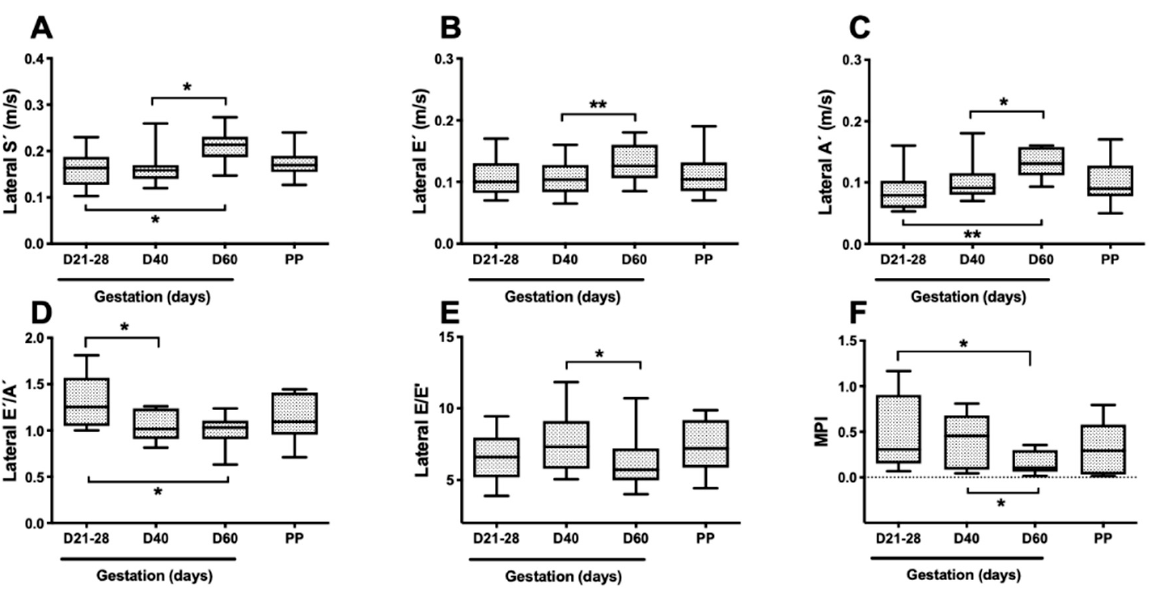
Figure 1. Box and whiskers plot showing LV systo-diastolic function assessed by TDI ( A – E ) and MPI ( F ). TDI parameters were obtained at the lateral margin of the mitral annulus. S’, peak systole in ejection phase; E’, peak myocardial velocity during early diastole; A’, peak myocardial velocity during atrial contraction; E, mitral peak flow velocity during early diastole. Thick line, box, and whiskers stand for median, interquartile range, 5th and 95th percentiles, respectively. * p < 0.05; ** p < 0.01.